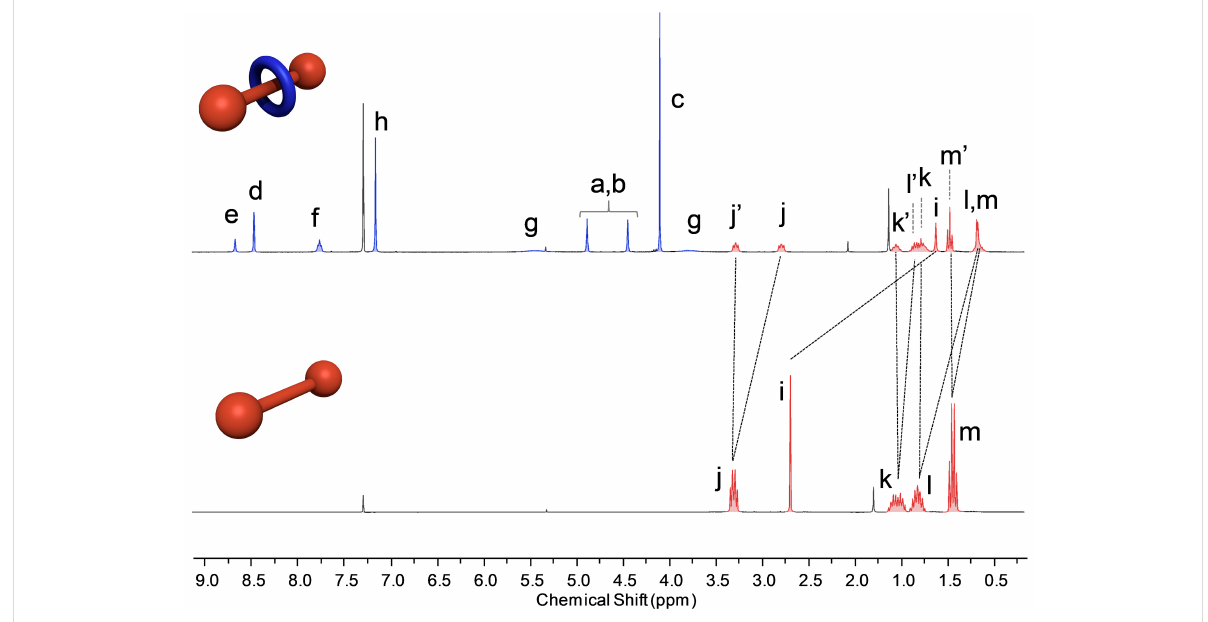
Figure 4: 1 H NMR spectrum (300 MHz) of rotaxane 1a (top) and thread 4a (bottom) in CDCl 3 (a designation of the signals is described in Figure 2).